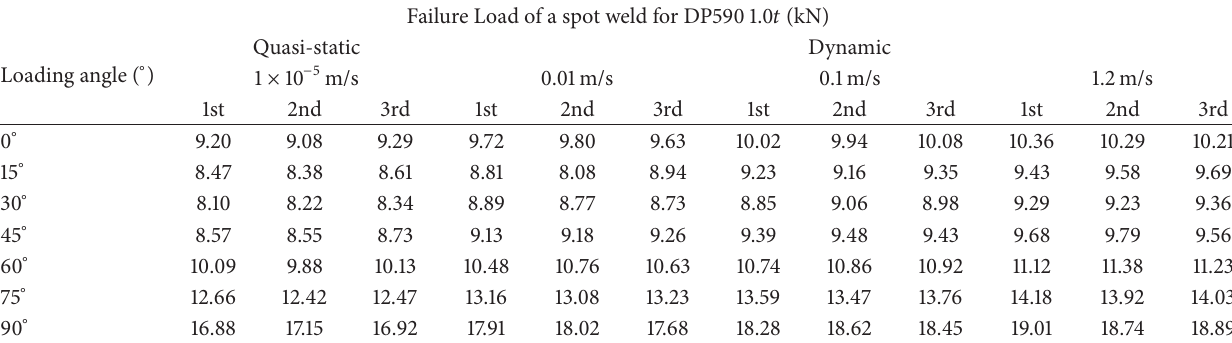
Table 3: Dynamic failure loads of a spot weld for DP590 at various loading